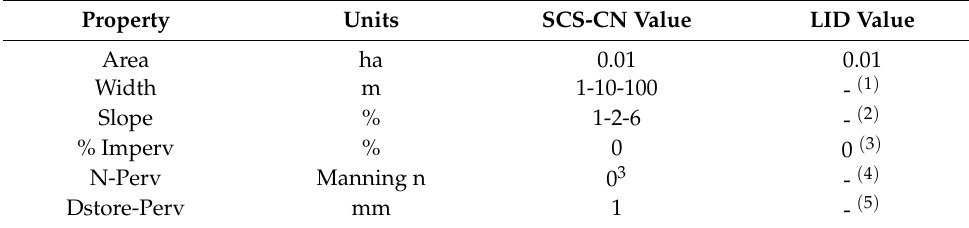
Table 1. SWMM parameters for subcatchment.